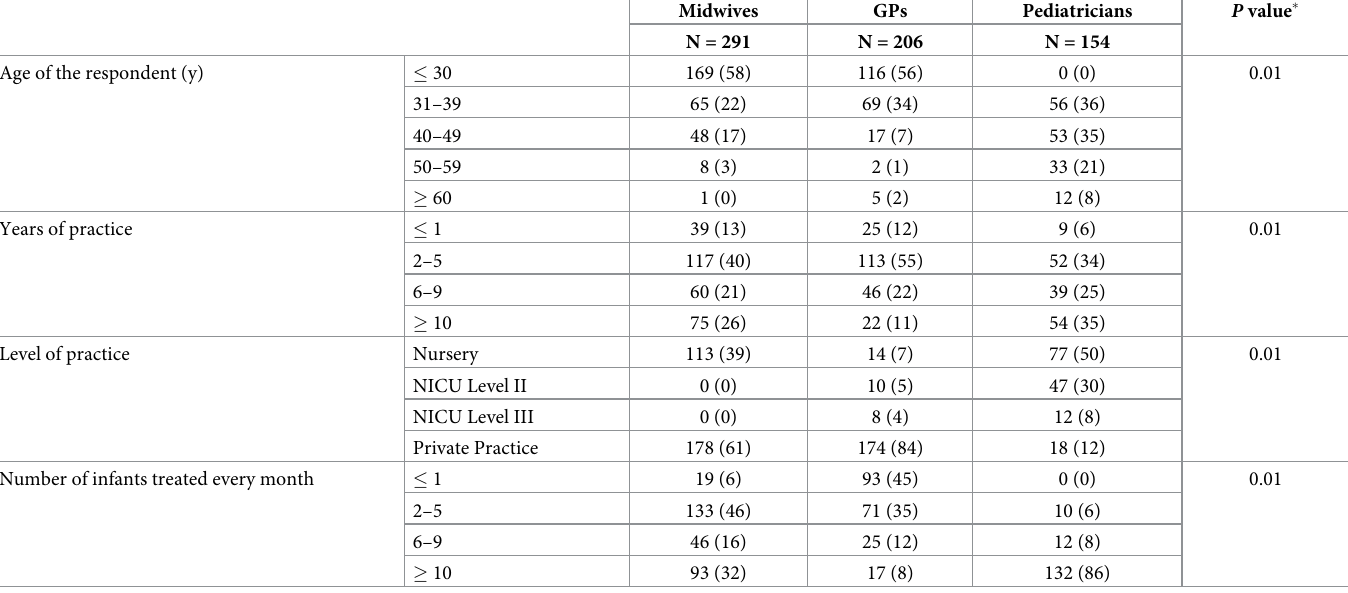
Table 1. Demographic characteristics of the